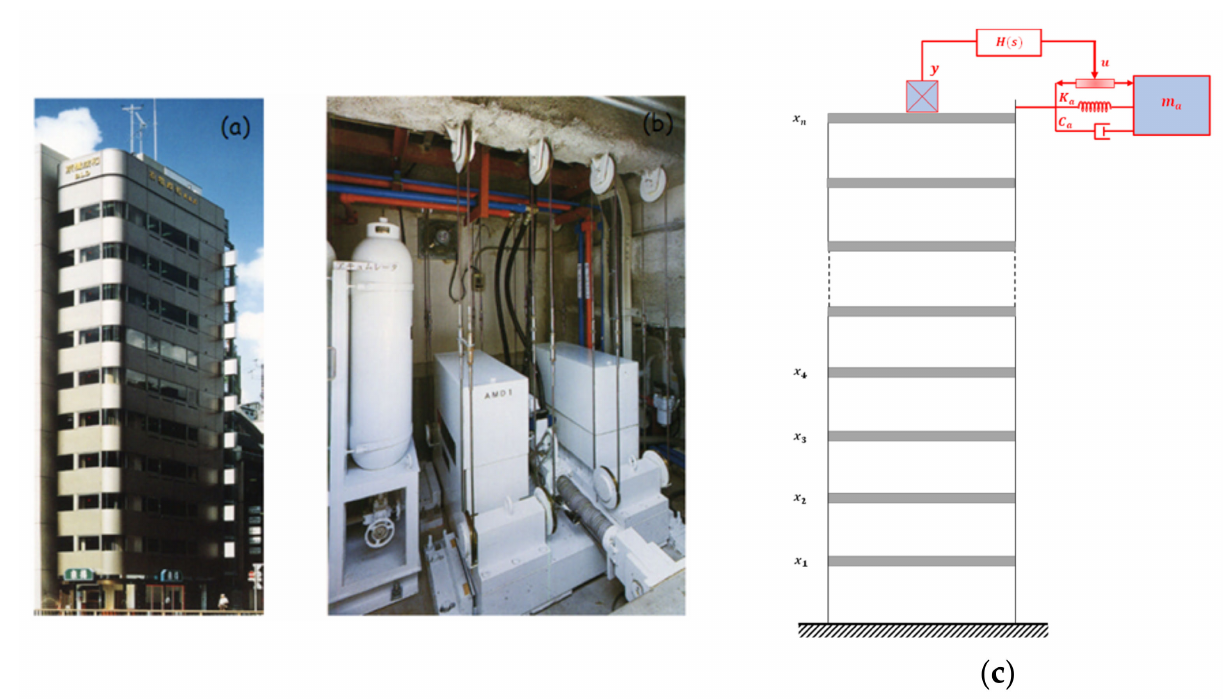
Figure 15. ( a ) Kyobashi Siewa Center (Japan) and ( b ) its AMD unit; ( c ) model of a building equipped with an AMD on the top